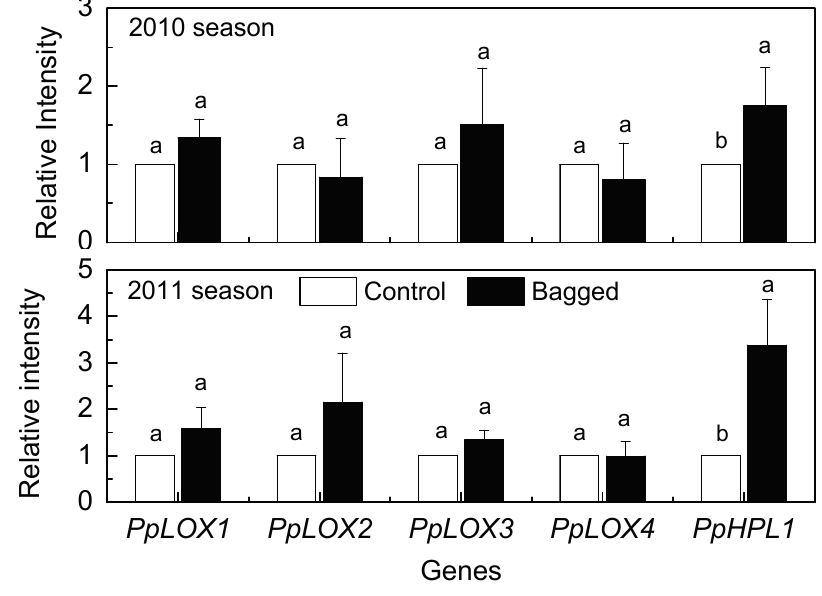
Figure 2. Effect of bagging treatment on the expression of PpLOXs and PpHPL1 in peach fruit skin. Each value represents the mean ± standard error of three replicates. The significant differences are indicated with different letters (LSD,